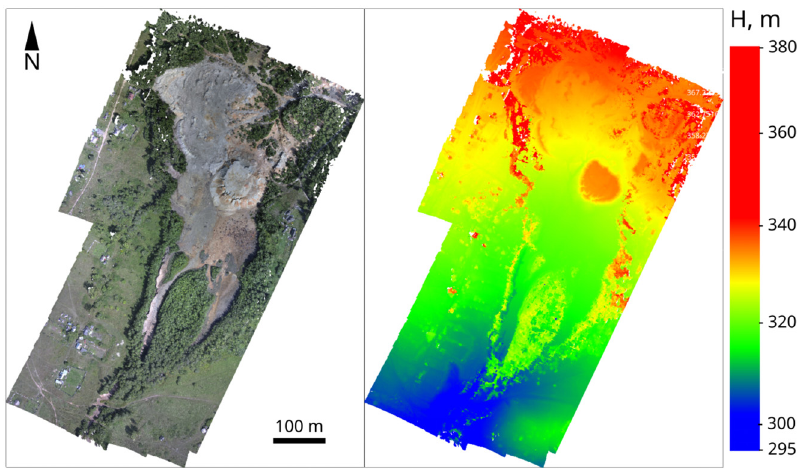
Figure 9. Orthophotoplane and digital elevation model.